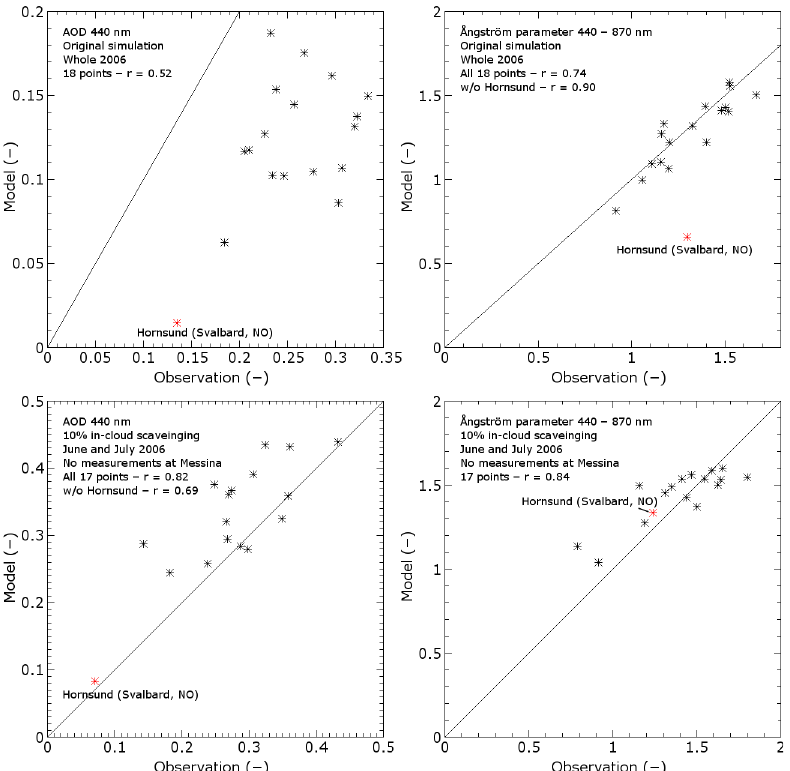
Fig. 7. Comparison between modelled and observed AOD (440nm) and ˚Angstr¨om parameter (440–870nm) at AERONET stations. Above: Original results (average over whole 2006). Below: simulation with in-cloud scavenging rates scaled down by a factor of 10 (average over June and July